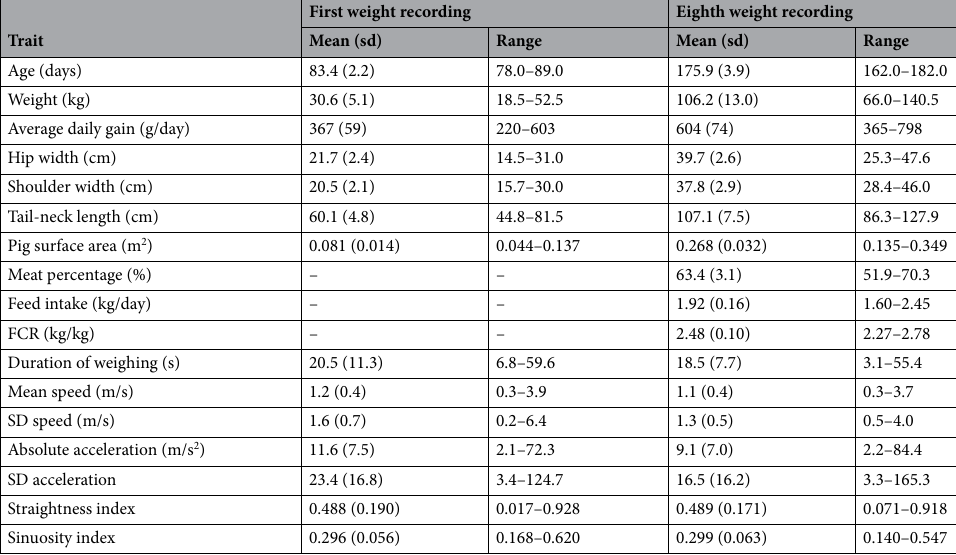
Table 3. Descriptive statistics of most important traits for the first recording, thirteen days after arrival of pigs in the fattening farm (N = 1176) and for the last (eighth) recording (N = 743). Activity traits shown are derived from the tail base. Note that the traits meat percentage, feed intake (pen level) and feed conversion ratio (pen level) were recorded after slaughter of pigs and do not completely correspond with the last video recording. The fastest growing pigs were slaughtered a few days after the last video recording, whereas this took more than 30 days for the slowest growing pigs. FCR Feed Conversion